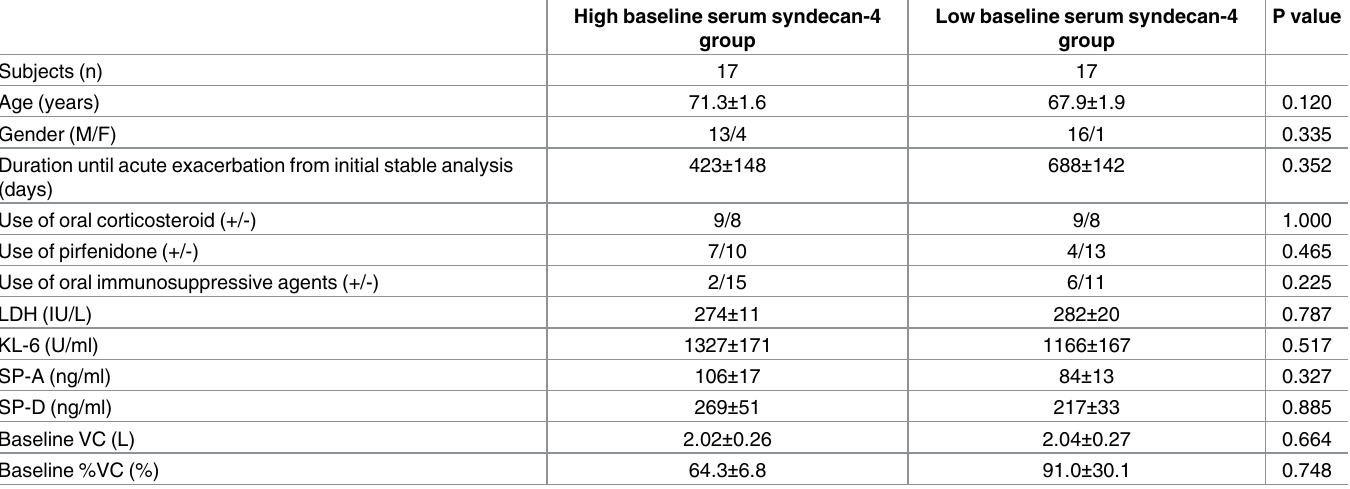
Table 3. Clinical characteristics of idiopathic interstitial pneumonia patients with high and low baseline serum syndecan-4 levels.